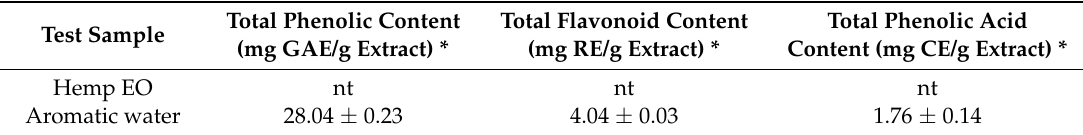
Table 3. Total bioactive compounds in Cannabis sativa extract samples.